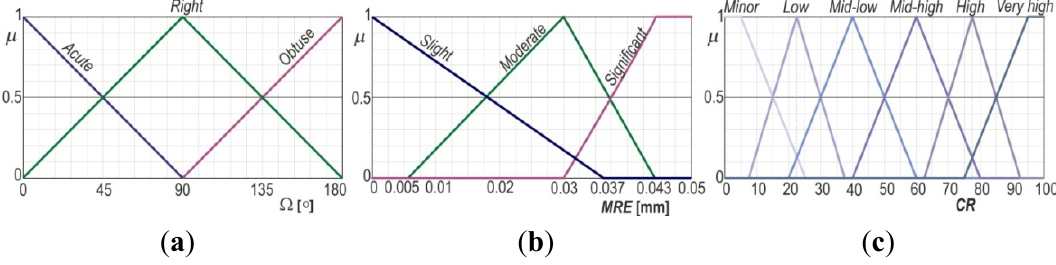
Figure 8. ( a ) Membership function of input state variable Ω . ( b ) Membership function